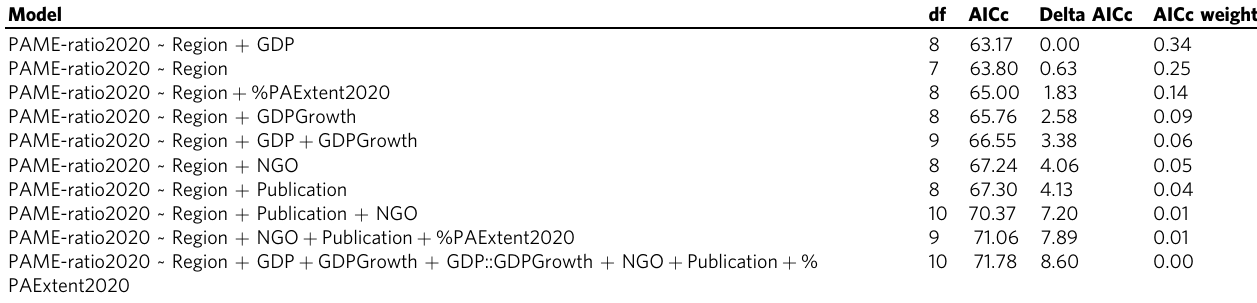
Table 3 Results of generalized linear models testing different hypotheses on the association between the ratio of PAs with management effectiveness (PAME) in 2020 and ecological and geopolitical factors in Asian